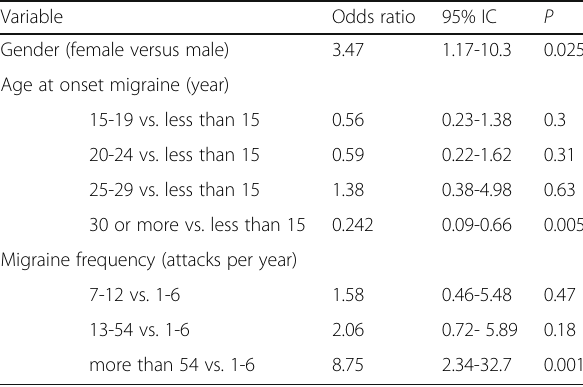
Table 4 Multivariate logistic regression model – factors associated with IWPH among those with episodic migraine